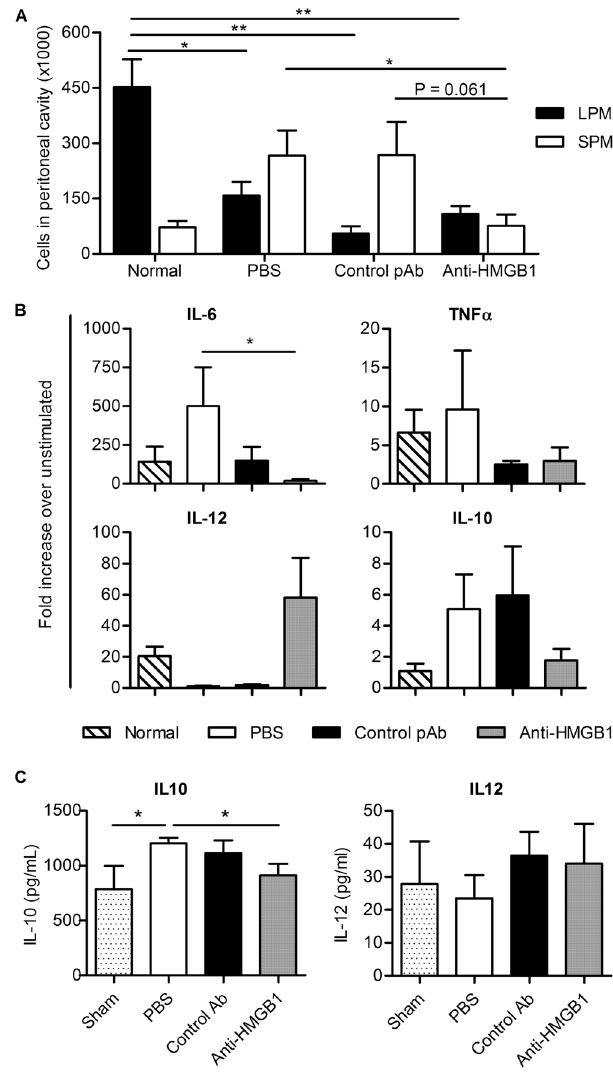
Figure 7. Anti-HMGB1 pAb treatment alters macrophage and DC cytokine expression post survival from CLP-induced sepsis. Peritoneal cells were harvested four days following CLP surgery and treatment with either PBS (n = 4), control ovine pAb (n = 4) or anti-HMGB1 pAb (n = 5) and evaluated via flow cytometry. Frequency of large peritoneal macrophages (LPM; CD11b hi , F4/80 hi , Gr-1 + ) and small peritoneal macrophages (SPM; CD11b lo , F4/80 lo , Gr-1 − ) compared to normal mice (n = 2) are expressed ( A ; Mean + SEM). Adherent macrophages from peritoneal lavages were stimulated with LPS (100 ng/mL) for 18 hours and IL-6, IL-10, IL-12 and TNF α content in the supernatant was evaluated via ELISA. Mean + SEM expression for each treatment relative to unstimulated wells is expressed ( B ). Bone marrow cells harvested from Day 4 septic or sham-surgery mice were cultured in the presence of GM-CSF to generate bone-marrow derived dendritic cells (BMDCs). Harvested BMDC’s were plated and cultured in the presence of LPS (100 ng/mL); Mean + SEM IL-10 and IL-12 cytokine content of resulting supernatants is expressed ( C ). Mean values of individual groups were compared via two-tailed t tests, with significance denoted as thus: ** P < 0.01, * P <